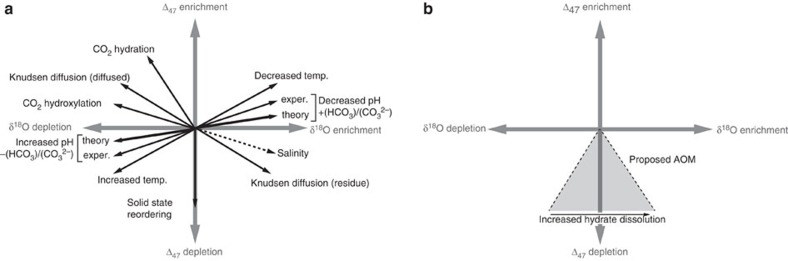
Various controls on Δ47 values.(a) In addition to temperature20, diffusion, salinity, pH and CO2 hydration/hydroxylation reactions have been shown to influence the clumped isotope compositions of carbonates404145464952. CO2 hydroxylation and hydration are pH sensitive, with hydroxylation favored at higher pH46. Solid-state re-ordering may also impact carbonates, with increased rates at higher temperatures and greater potential for re-ordering in older rocks2270. Mixing has been shown to produce variability in multiple trajectories19. Increased salinity produces δ18O enrichment and Δ47 depletion, however the specific slope can vary. (b) Hypothesized influences by AOM reactions and hydrate dissolution.